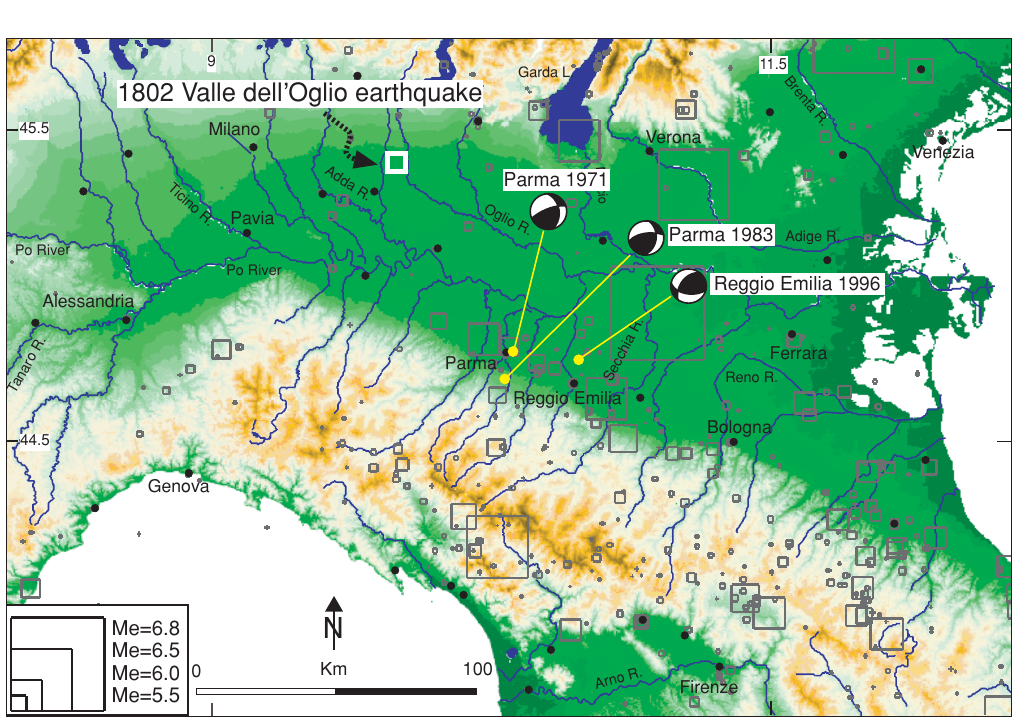
Fig. 2. Historical seismicity of the Po Plain (CPTI, Working Group, 1999). The focal mechanisms of the three largest instrumental earthquakes recorded in the area are consistent with ongoing N-S contraction. In contrast, seismicity recorded in the inner portions of the Apennines chain is mainly extensional. Only a few earthquakes are reported north of the Po River, and seismicity does not follow a regular